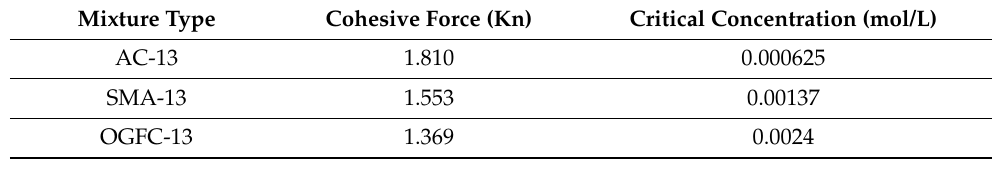
Table 10. The critical concentration of the mixture corresponds to the bonding force.